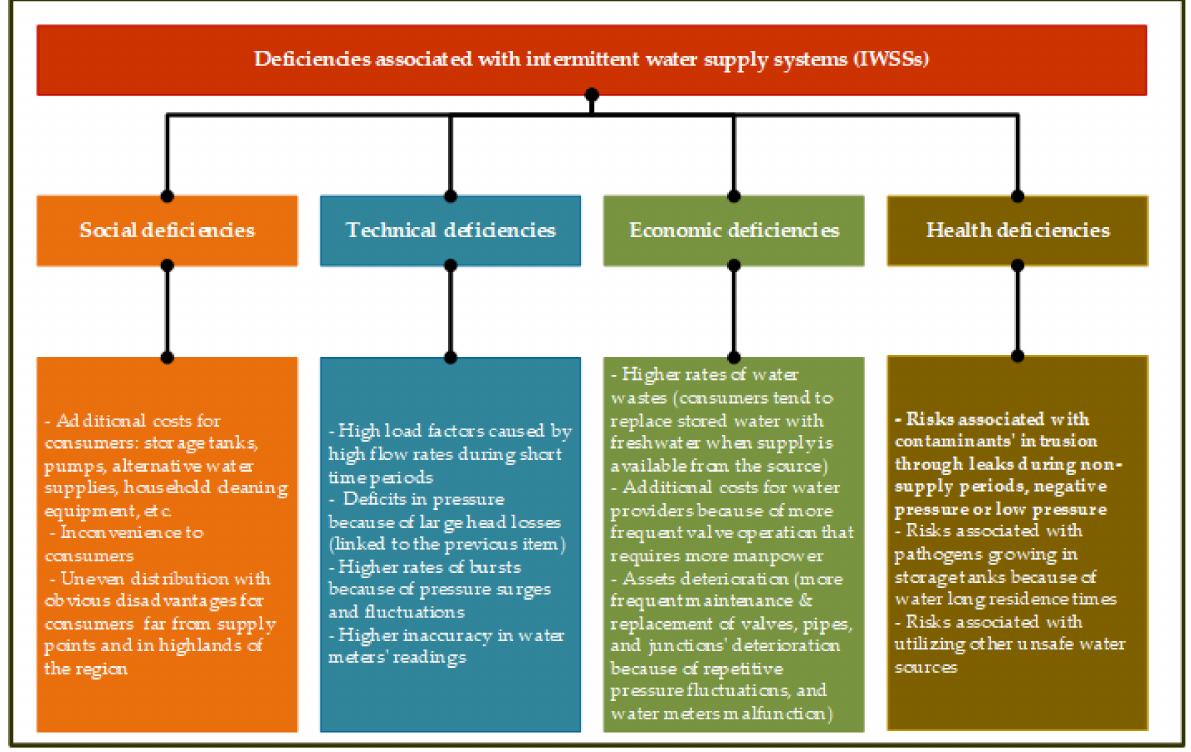
Figure 1. Major social, technical, economic, and health flaws associated with the adoption of intermit- tent water supply systems (IWSSs), modified after Zyoud